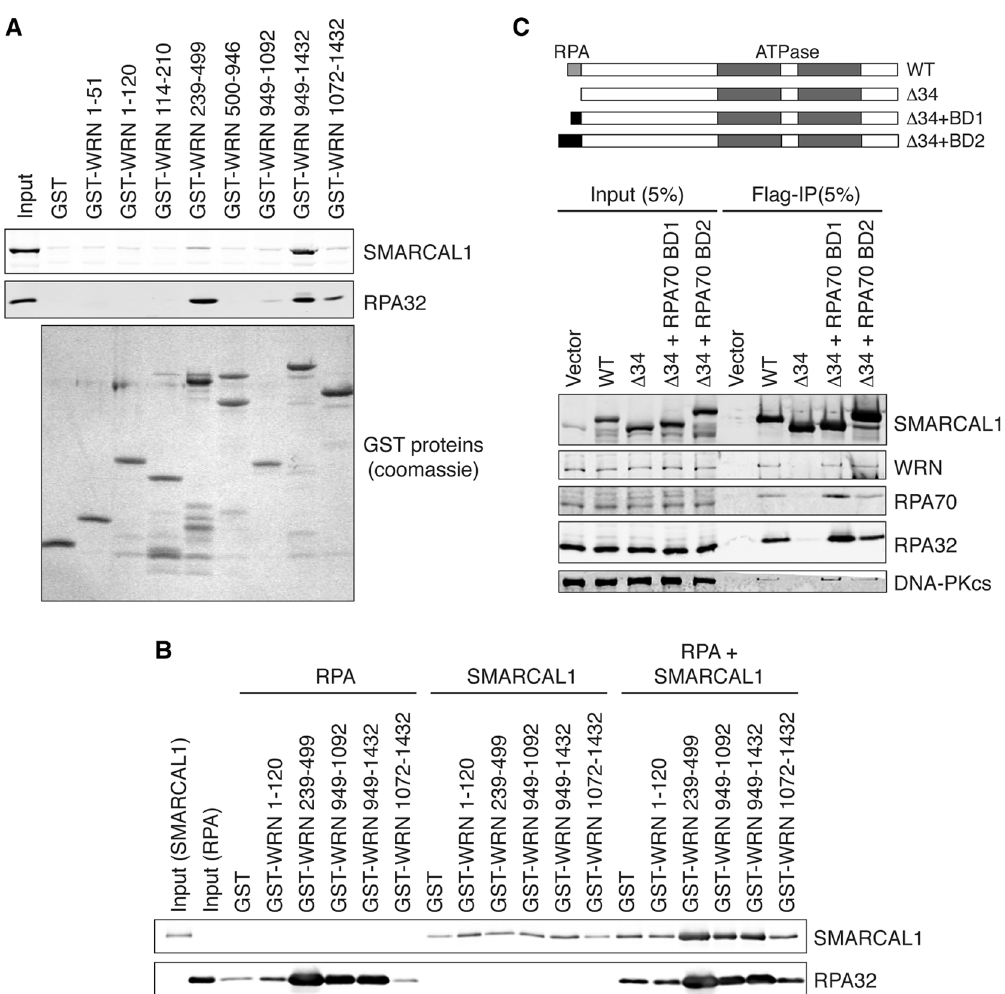
Figure 3. RPA acts as a scaffold to mediate the SMARCAL1-WRN interaction. (A) GST-WRN proteins bound to glutathione beads were incubated with HeLa nuclear extracts. After extensive washing, bound proteins were separated by SDS-PAGE and immunoblotted with antibodies to SMARCAL1 or RPA32. A coomassie stained gel was also prepared to document the amount of GST proteins added to the lysates. (B) Recombinant RPA, SMARCAL1, or both proteins were incubated with GST-WRN fragments bound to glutathione beads. After washing, bound proteins were separated by SDS-PAGE and immunoblotted with the indicated antibodies. (C) Flag immunoprecipitates from 293T cell lysates after transfection with Flag-SMARCAL1 wild-type (WT) or mutant expression vectors were separated by SDS-PAGE and immunoblotted with the indicated antibodies.